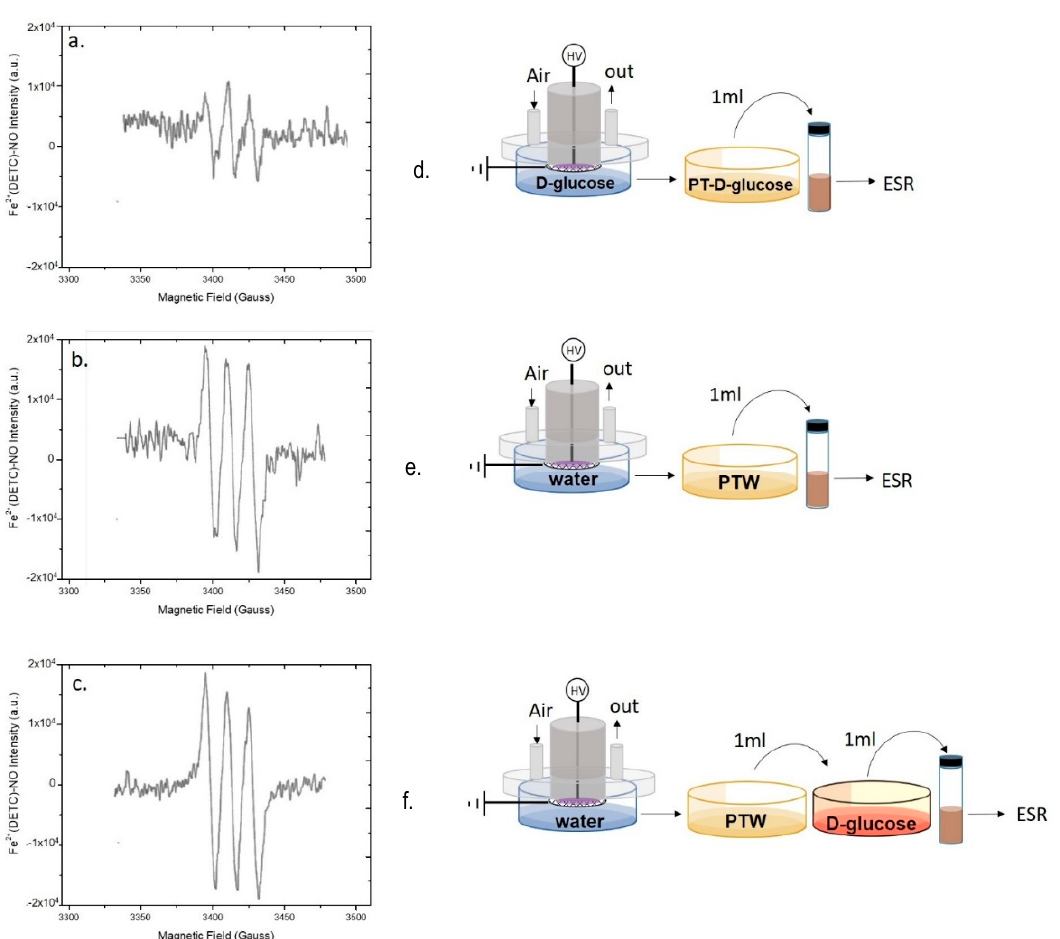
Figure 6. Role of D-Glucose in scavenging plasma produced • NO. EPR spectra of ( a , d ) Plasma Tretaed- D-glucose (PT-D- glucose) solution (45 mg L − 1 ), ( b , e ) PTW, and ( c , f ) PT-D-glucose solution mixed with PTW 15 min before spectra acquisition. Experimental conditions: 0.5 slm Air, 50% DC, 100 ms period, 6 kHz, 13kV, 2 mL solution, 15 min treatment time. Schemes of the experimental procedures used for EPR analysis are reported on the right of each spectrum.